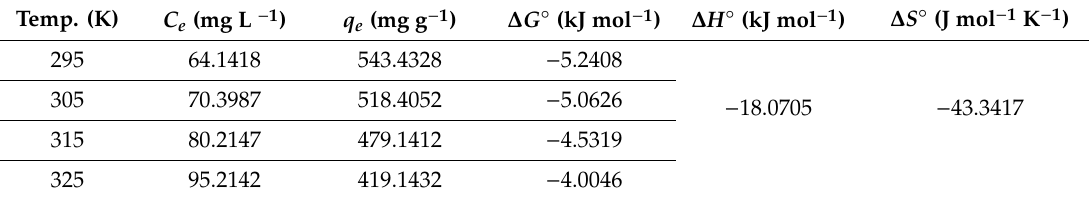
Table 4. Parameters for adsorption of RhB on MIL-100 (Fe) @Fe 3 O 4 @AC. (C 0 = 200 ppm, agitation speed = 230 rpm, adsorbent dosage = 0.25 g / L, temperature = 295–325 K). Temp.